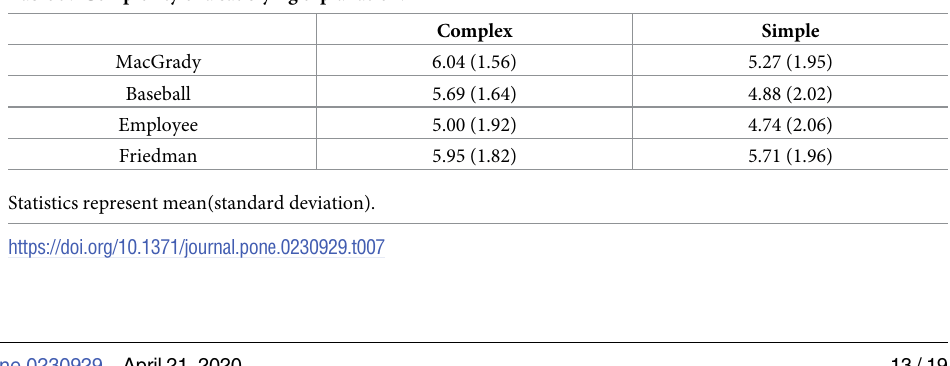
Table 7. Complexity of a satisfying explanation.